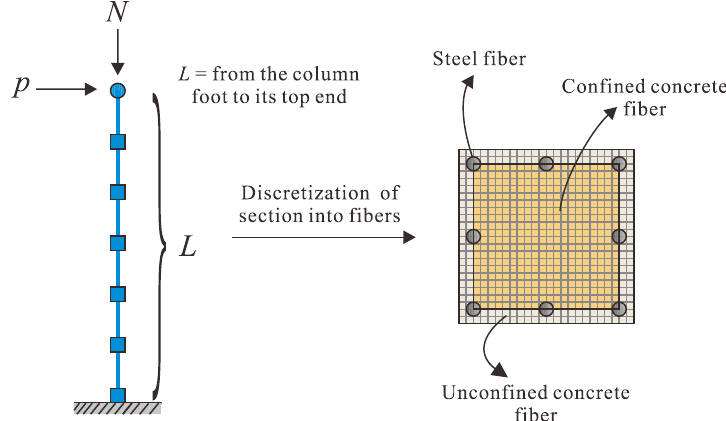
Figure 1. Loading scheme, boundary conditions, and fiber discretization for reinforced recycled concrete (RRC) columns.